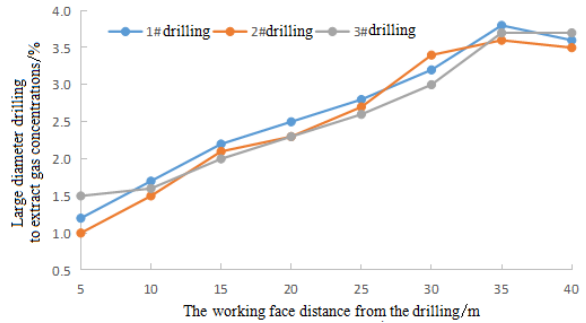
Figure 8. Variation of the methane concentration in three boreholes.